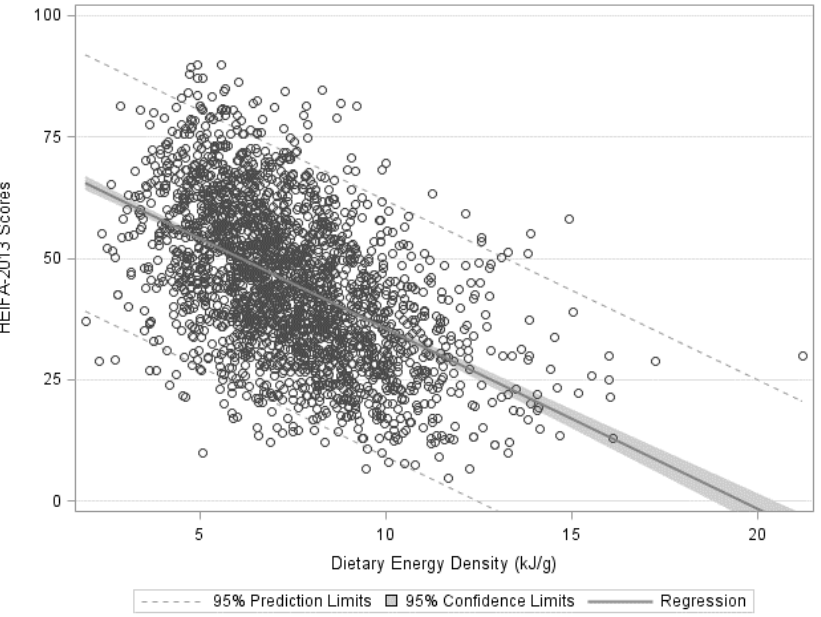
Figure 1. Diet quality of young Australian adults as measured with the Healthy-Eating-Index-for-Australian’s (HEIFA-2013) for different dietary energy-density (kJ/g).